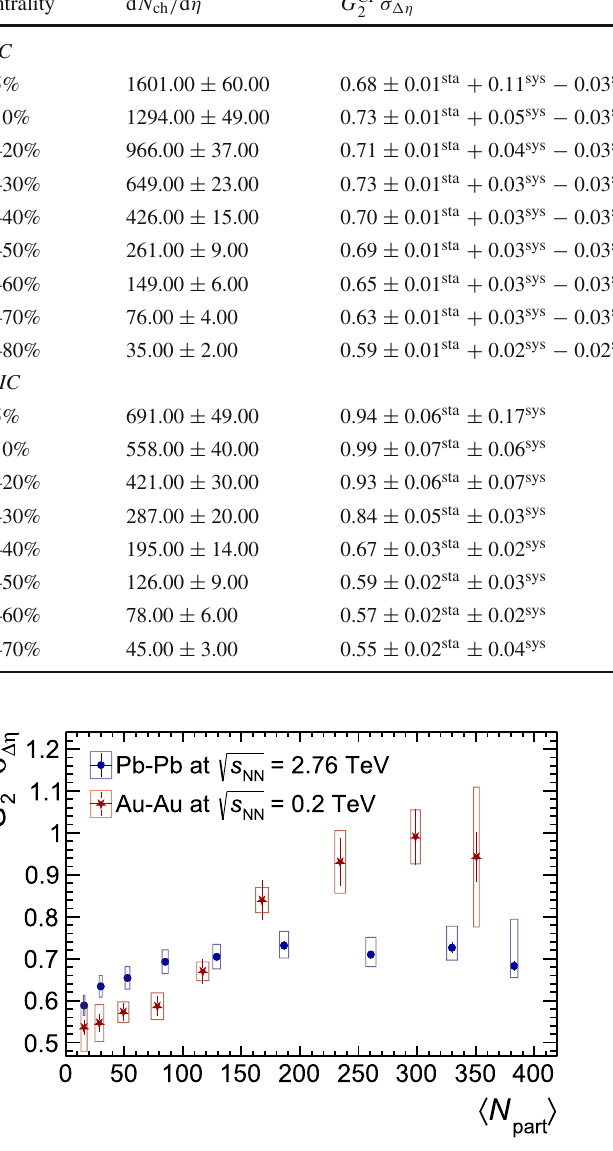
√ s NN = √ s NN = 200 GeV [16]. Error